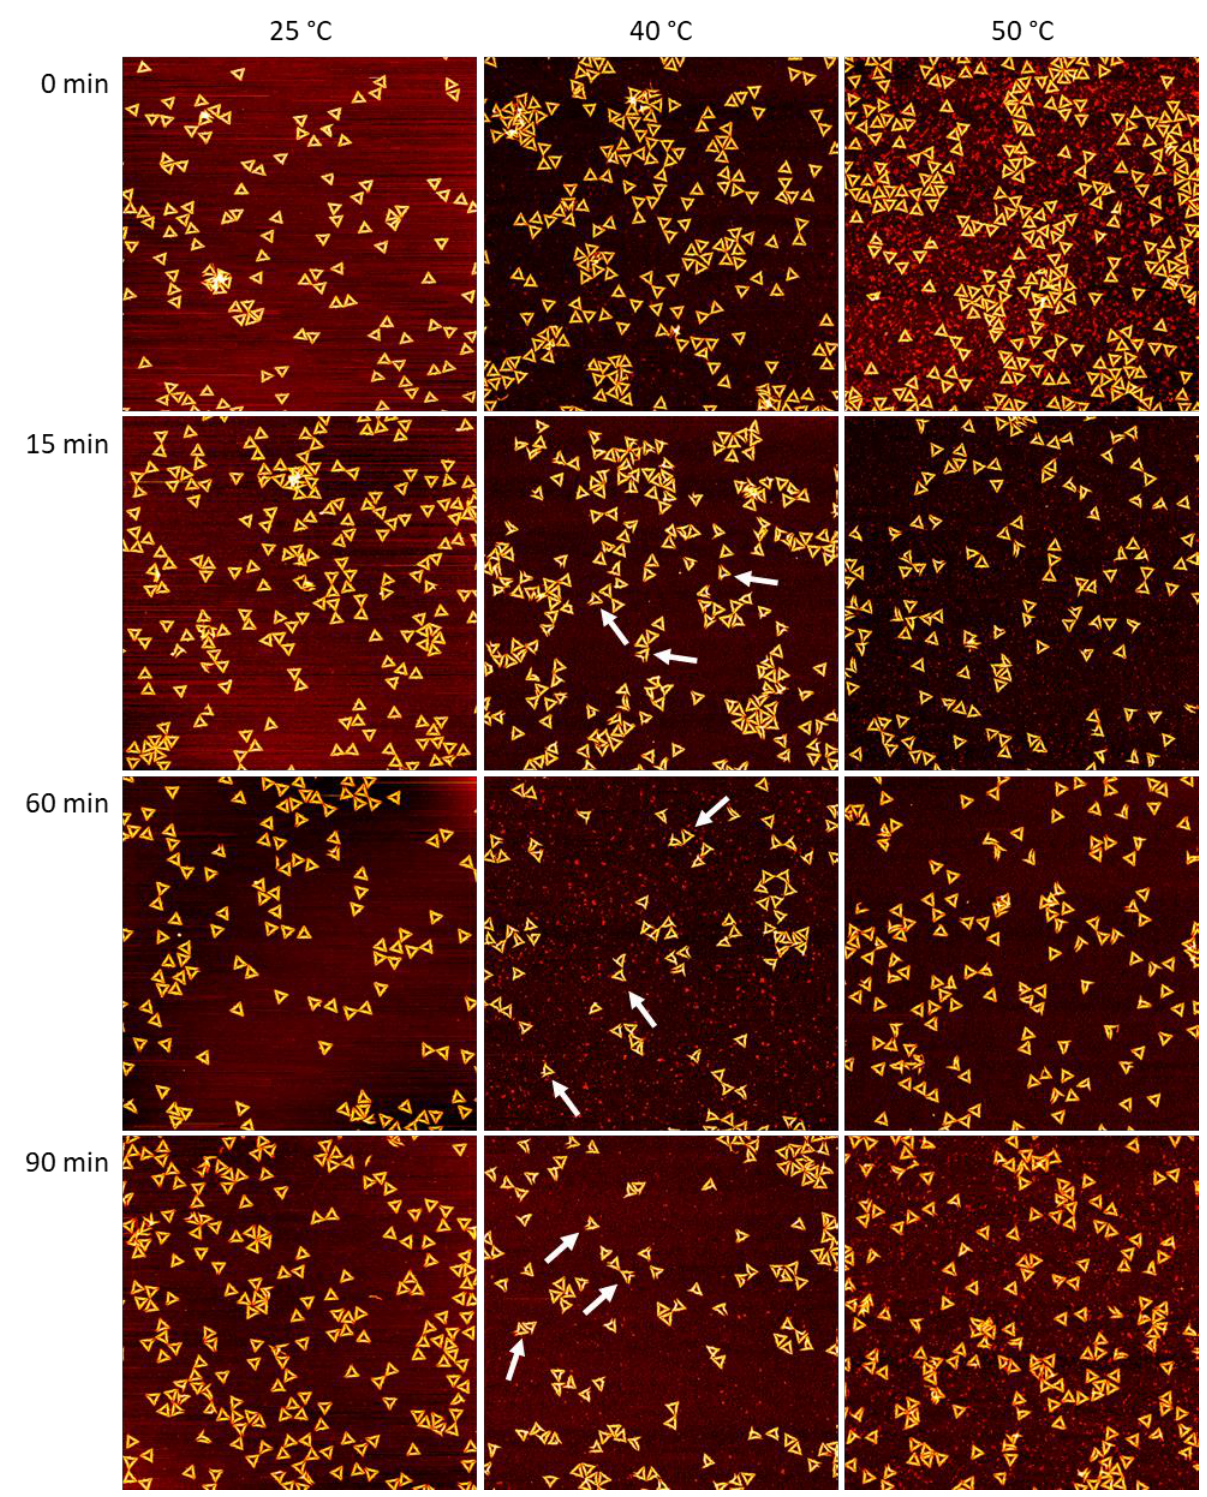
Figure 3. AFM images of DNA origami triangles after incubation in 2 M Gdm 2 SO 4 at different times and temperatures. Images have a size and height scale of 3 × 3 µm 2 and 2 nm, respectively. The white arrows indicate damaged yet mostly intact triangles with one or two ruptured vertices. For additional AFM images, see Figures S4 – S6.